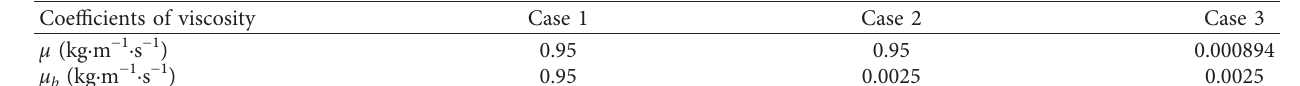
Table 2: The values of coefficients of viscosity μ and μ